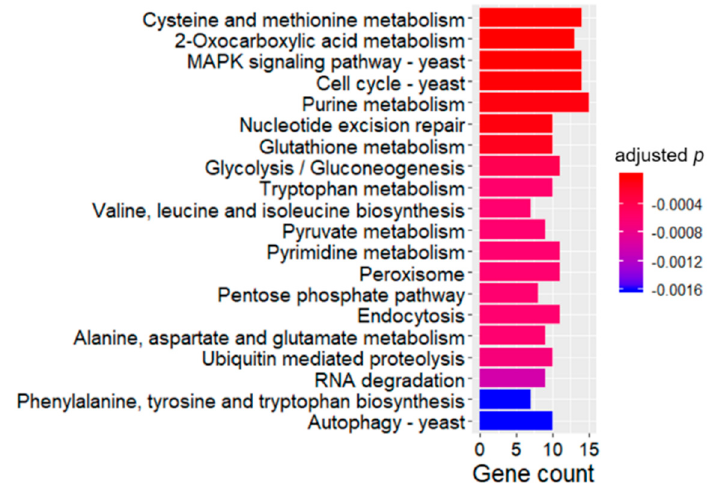
Figure 6. Enriched KEGG pathways of differentially expressed genes (DEGs). This figure shows top 20 pathways of KEGG enrichment analysis of common DEGs in PAE treatment and control groups.